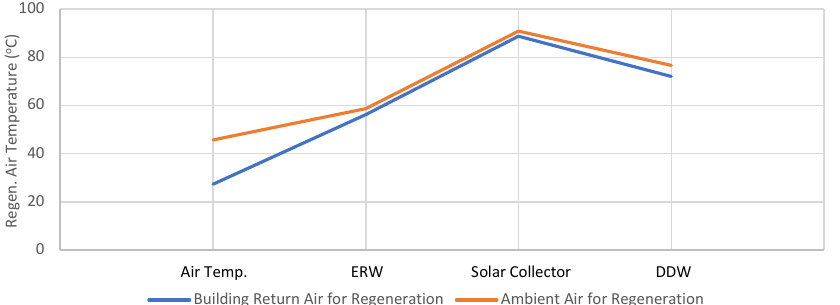
Figure 12. Comparison of the regeneration air temperatures through each component of the two different systems.